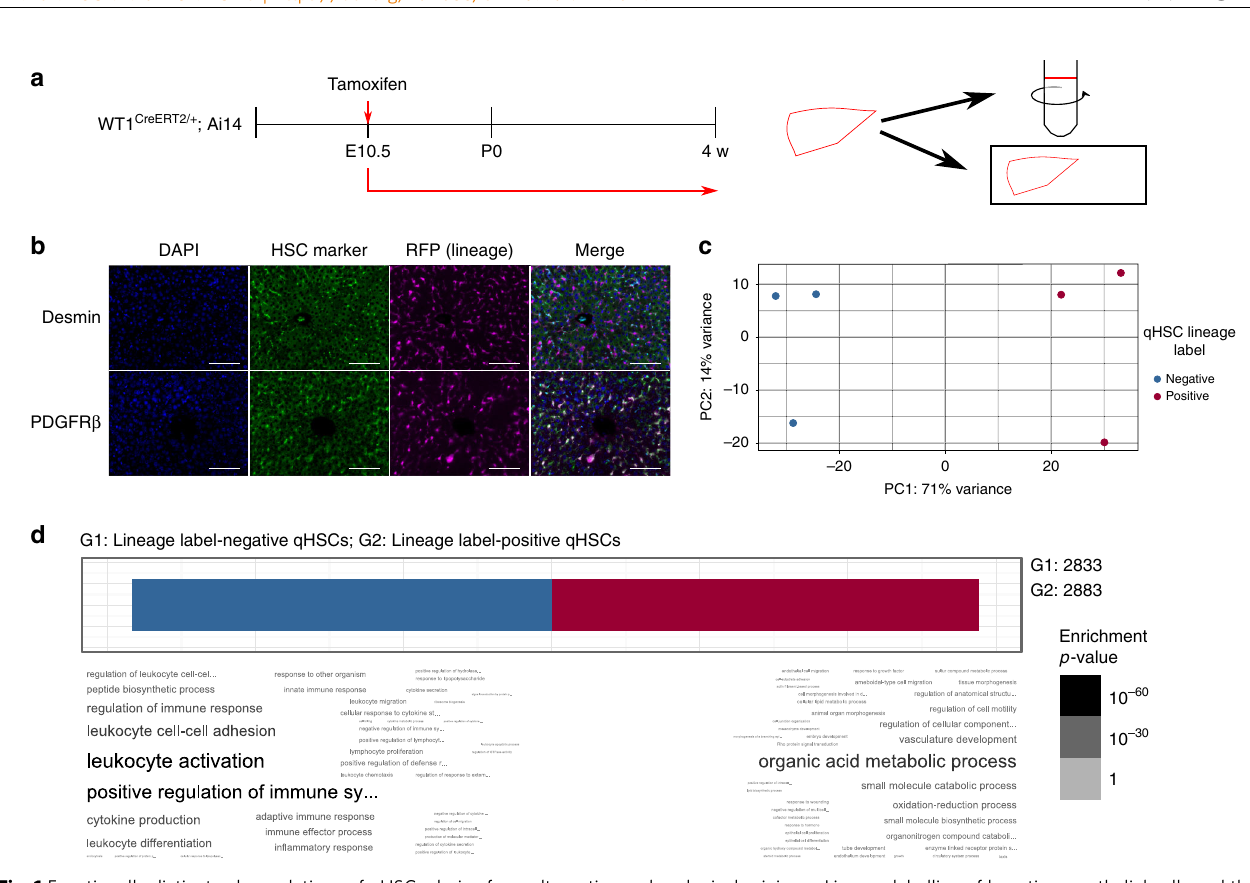
central vein was 27.0 ± 9.6 μ m compared with 69.4 ± 7.8 μ m for WT1-negative cells (Fig. 3e, Welch two-sample t -test, t (9.6195) = 8.4046, p = 0.0000098).